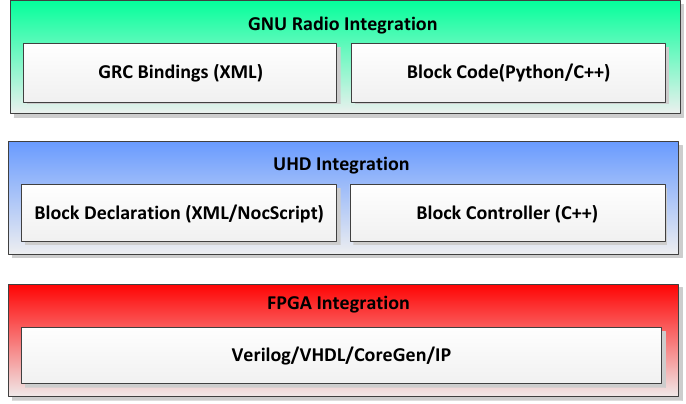
Figure 6. Components of the RFNoC module have three levels of content.